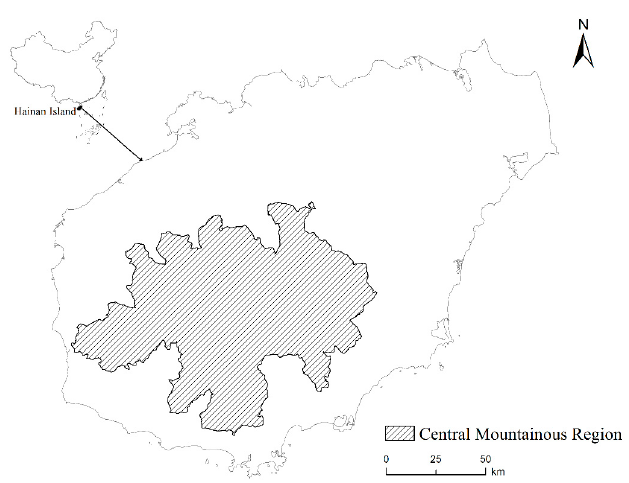
Figure 2. The central mountainous region of Hainan Island.